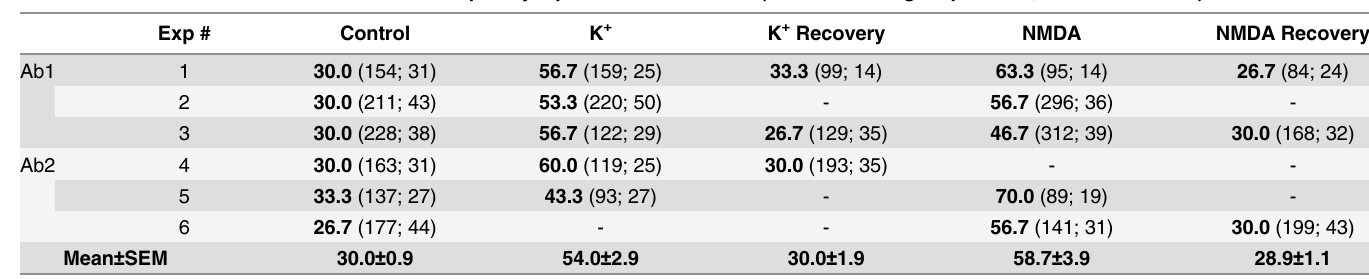
Table 3. Median distance of AIDA-1 label from the postsynaptic membrane increases under excitatory conditions and returns to basal values within 30 min after cessation of the stimulus. Median distance of label from postsynaptic membrane in nm (n = number of gold particles; number of